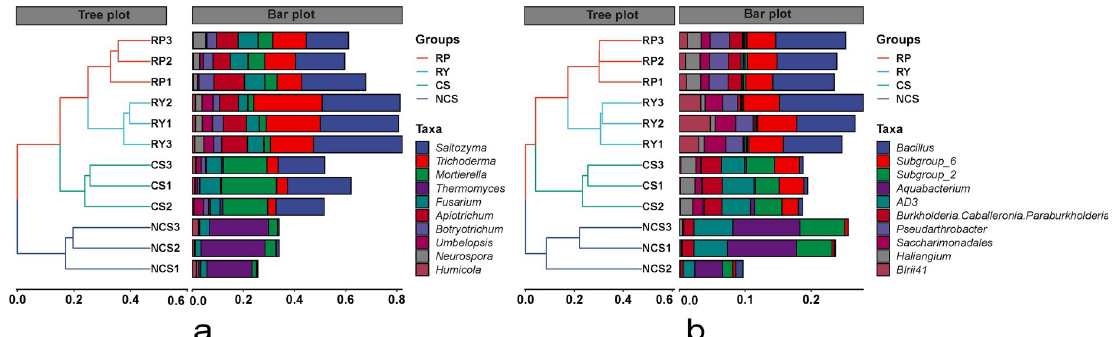
Fig 6. Hierarchical cluster analysis of fungi (a) and bacteria (b) in different soil and rhizosphere samples. The left diagram is a hierarchical clustering tree diagram according to the similarity between samples, and the right histogram is a stacked histogram of the top 10 genera. The phylogenetic trees were calculated using the neighbour-joining